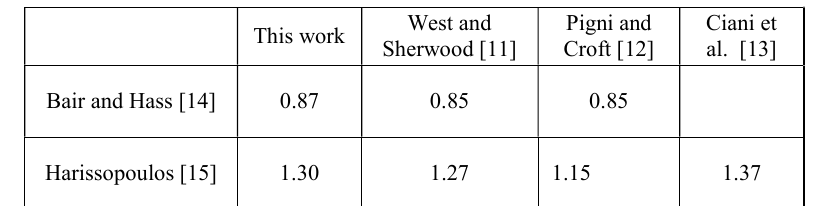
Table 2. Correction factors for 13 C(  ,n) experimental data proposed in this work compared with